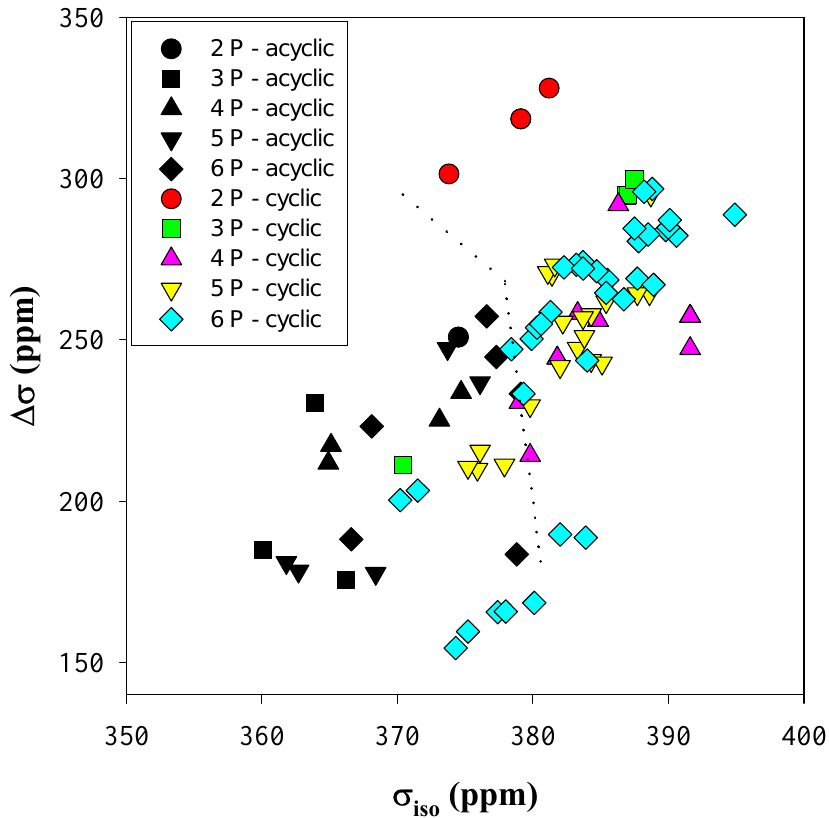
Figure 4. The calculated 31 P CSA isotropic chemical shielding ( σ anisotropy ( ∆σ ) for different sized acyclic and cyclic phosphate